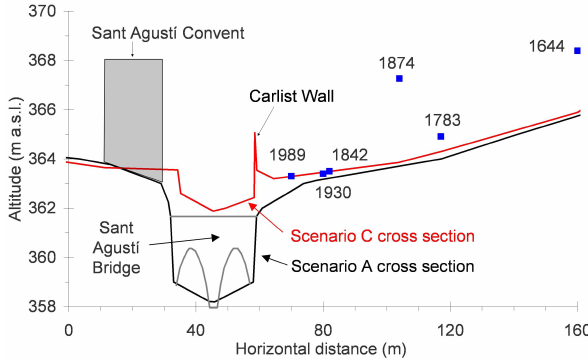
Fig. 7. Sant Agust´ı Street cross-section in scenarios A and C as seen from upstream with the six water height historical observa- tions found in Sant Agust´ı Street. Scenario A includes Sant Agust´ı- Bridge and Convent and Scenario C, the Carlist Wall, which is higher than 1930 and 1989 floods maximum heights, as explained in Sect. 3.1. (Horizontal axis marks the distance from an arbitrary spot on the left